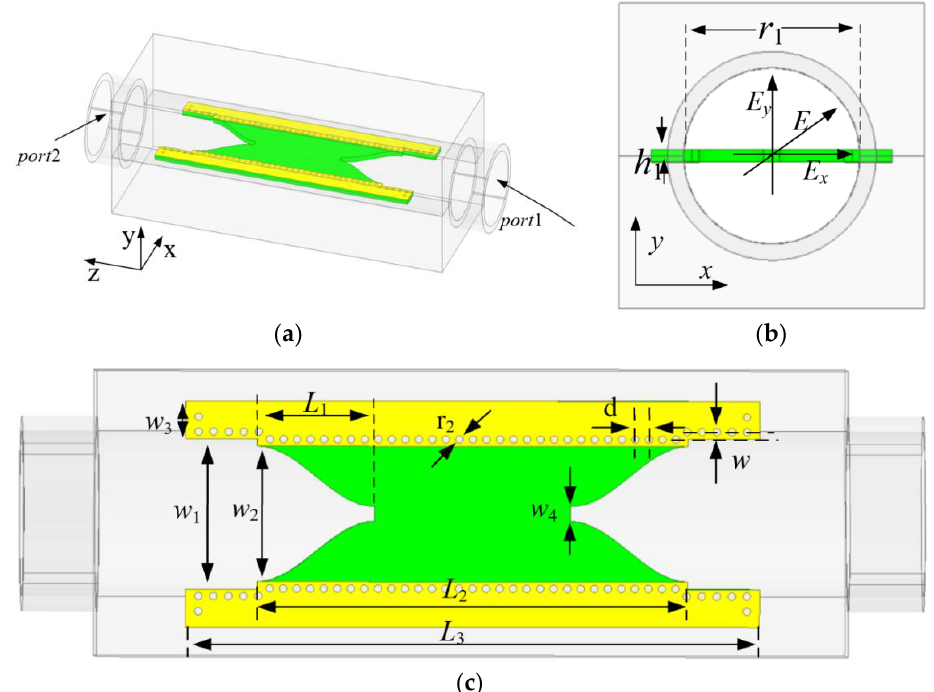
Figure 2. Dielectric plate circular polarizer: ( a ) Overall structure diagram. ( b ) Top view. ( c ) Cross- sectional view.